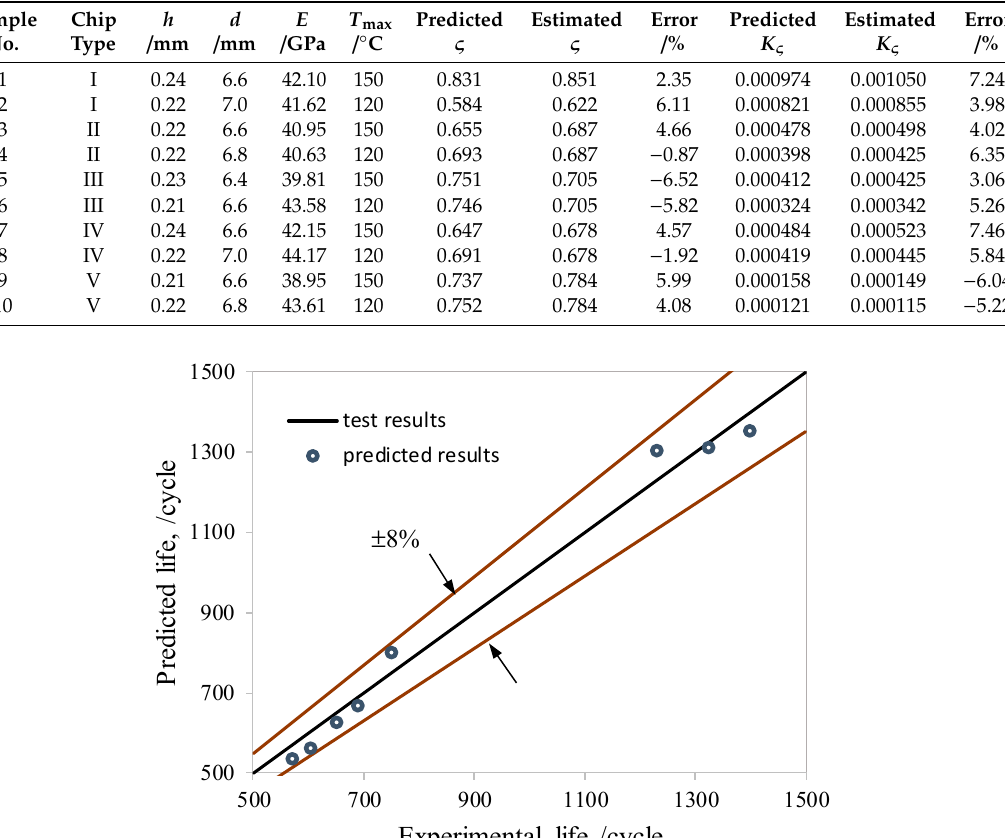
Table 4. Predicted singular parameters at the maximum strain state.